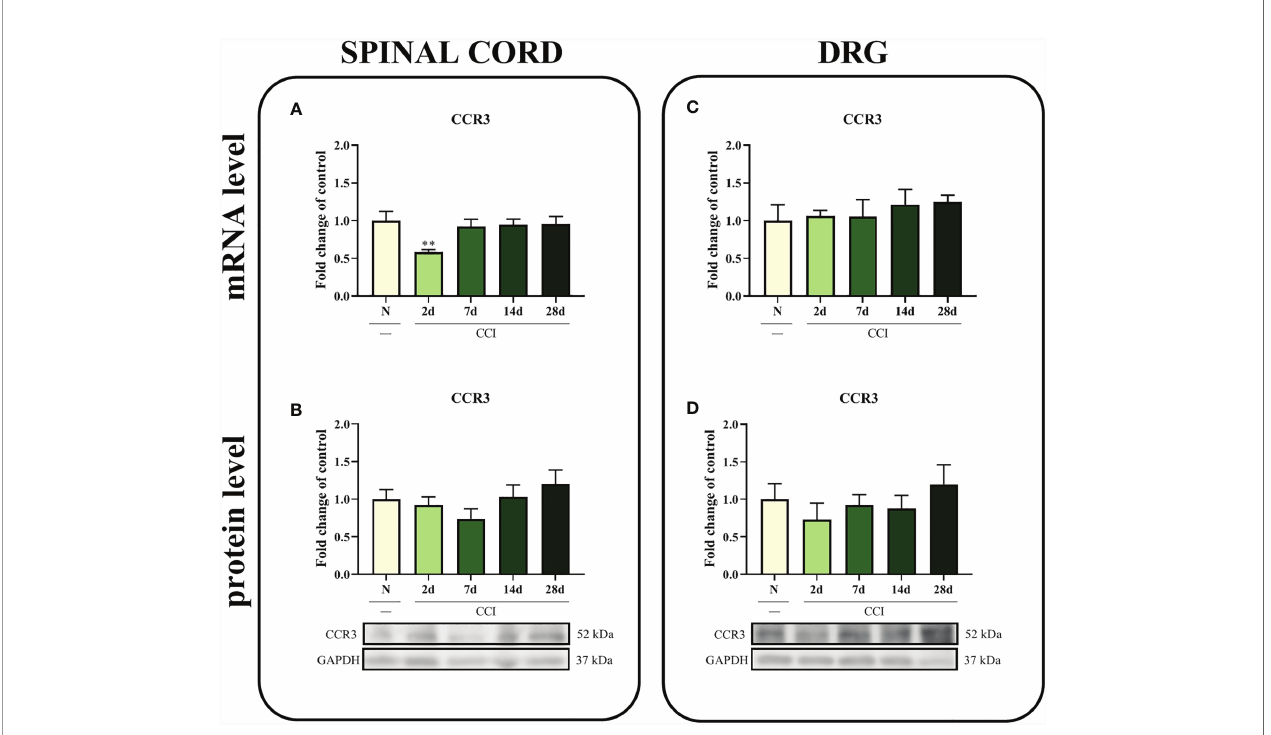
FIGURE 2 | Time-dependent changes in the CCR3 mRNA and protein levels in the rat spinal cord (A, B) and DRG (C, D) on the 2 nd , 7 th , 14 th and 28 th days after chronic constriction injury of the sciatic nerve (CCI). The biochemical data are presented as the mean fold changes relative to the control ± SEM (4 – 9 samples per group). Intergroup differences were analyzed using ANOVA with Bonferroni ’ s post hoc test for multiple comparisons. **P < 0.01 indicates a signi fi cant difference compared with the control group (naive, N